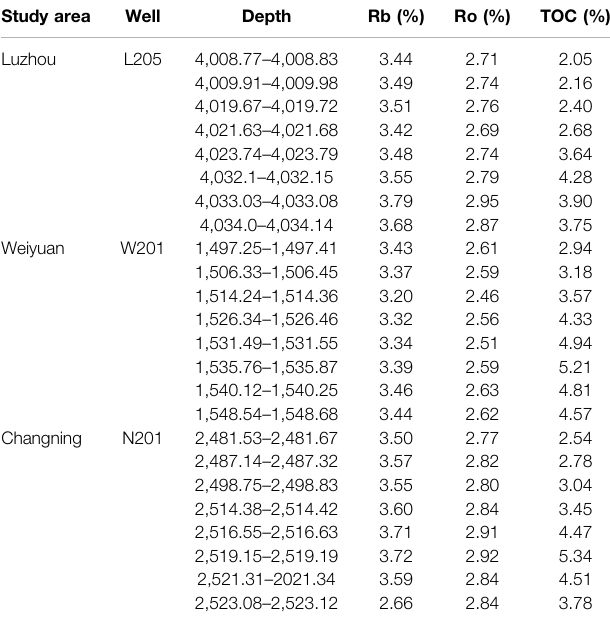
TABLE3| OrganicgeochemicalcharacteristicsofshalesintheWufeng-Longmaxi Formation in southern Sichuan. All experiments were performed at room temperature (26.5 ± 1 ° C).